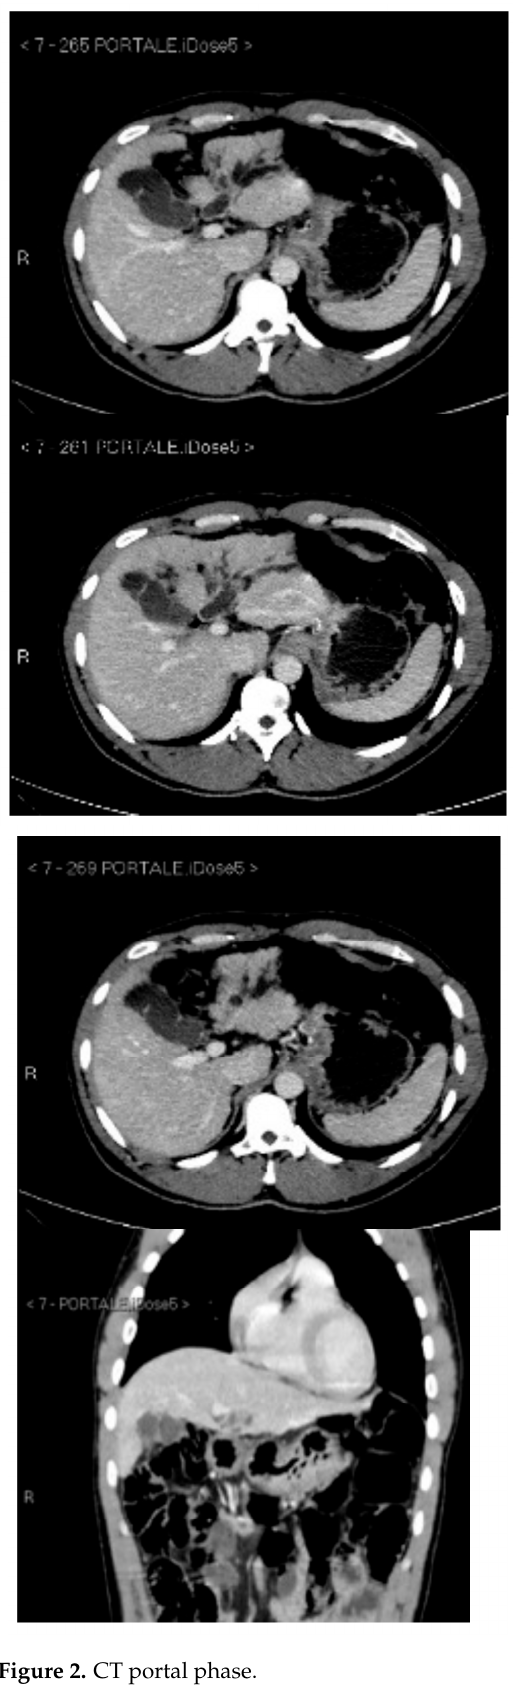
Figure 2. CT portal phase.